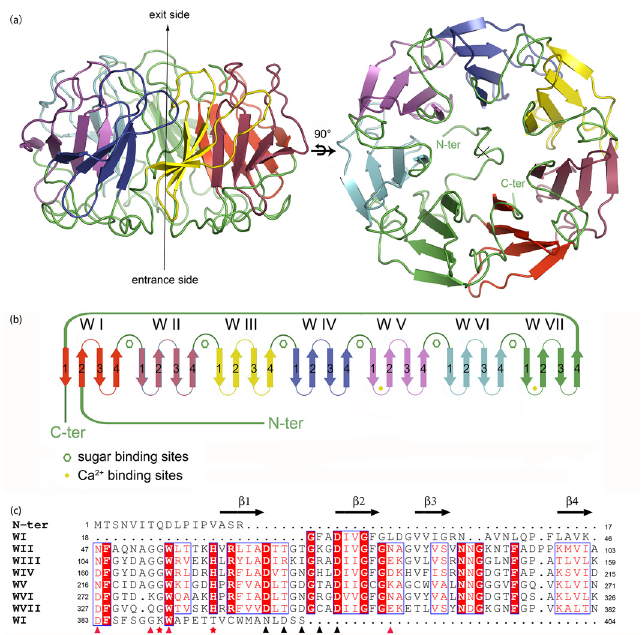
Fig 2. The overview of the structure of AAL2. (a) Two orthogonal views of the crystal structure of native AAL2. (b) Topology diagram of AAL2 shows that the seven blades have a shifting of one β -strand compared with the seven sequence repeats. GlcNAc binding sites and calcium binding sites are represented by green hexagons and solid yellow circles. (c) Alignment of the seven W-motifs of AAL2. Solid red triangles, black triangles, and red pentagons indicate the residues forming polar interactions with GlcNAc, the residues coordinate calcium ions, and the differences between WI and other W-motifs making it incapable of binding GlcNAc,